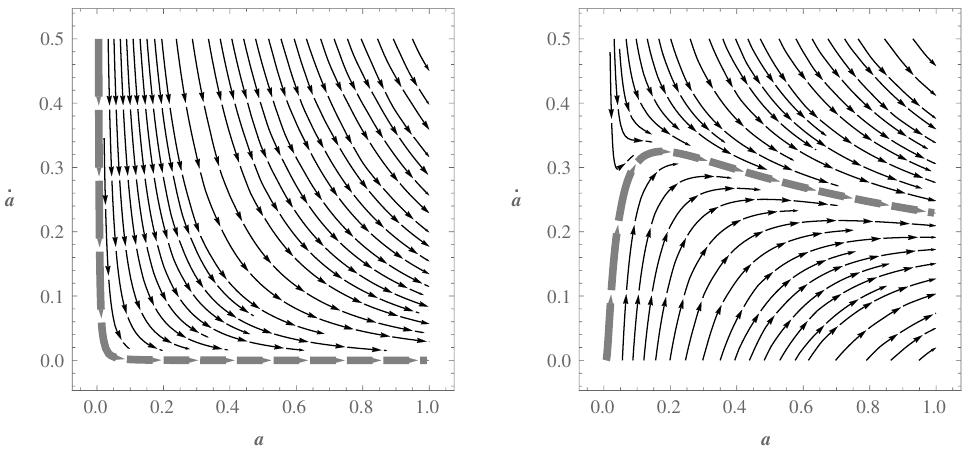
Figure 6. Phase space portrait for Equation (32). The left and right panels are associated with the commutative case ( θ = 0) and noncommutative case ( θ = − 0.001), respectively. We have also assumed n = 1, W = 2, 8 π G = 1, a i = 0.005 and φ i = 0.01 for both of the